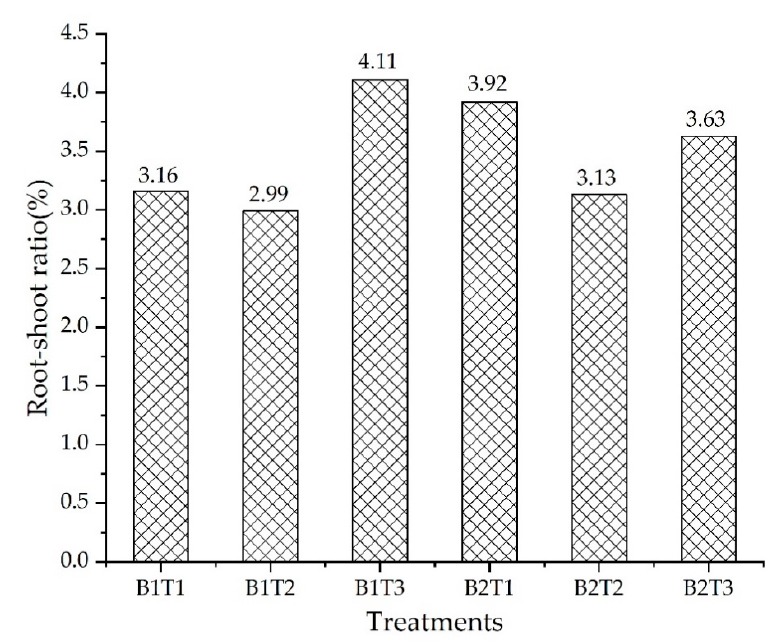
Figure 4. The influence of different nutrient solution irrigation treatments and downy mildew infection on the root–shoot ratio of cucumber.